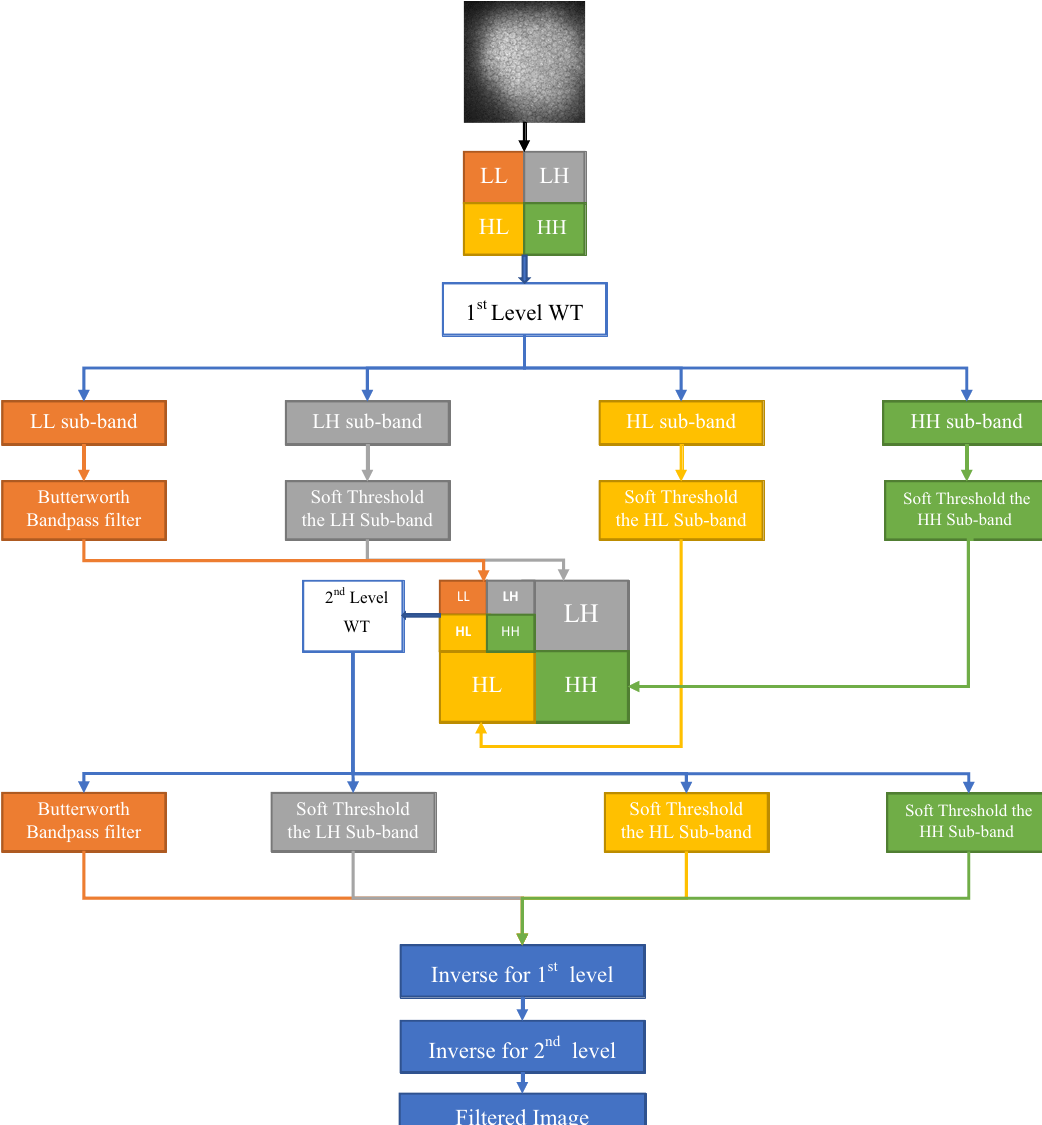
Figure 9: WTBBS schema for endothelial cell